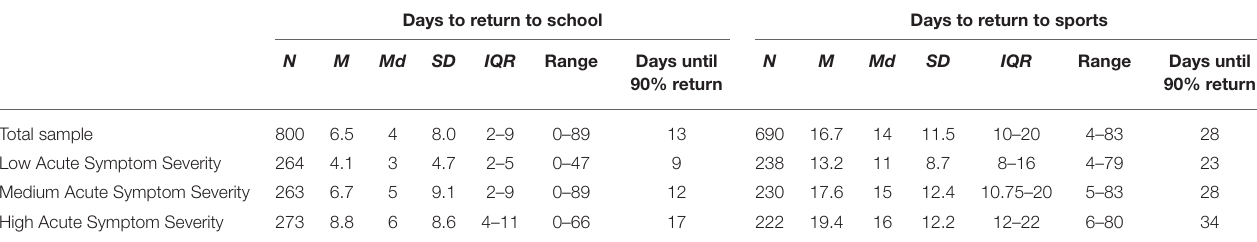
TABLE 2 | Number of days to return to school and sports by acute symptom